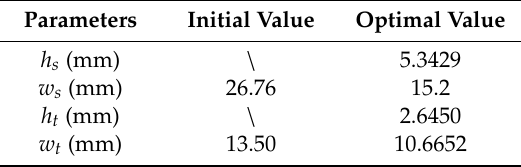
Table 6. Optimal tooth profile